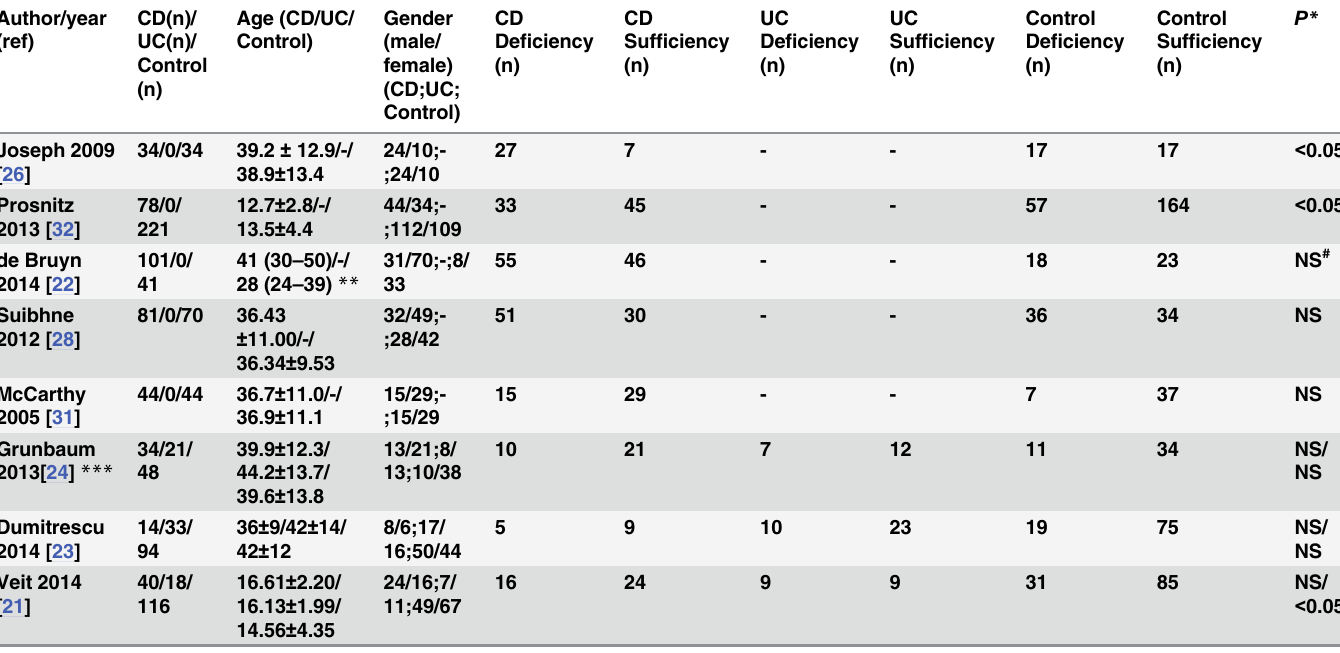
Table 2. Data for vitamin D deficiency among CD patients, UC patients, and